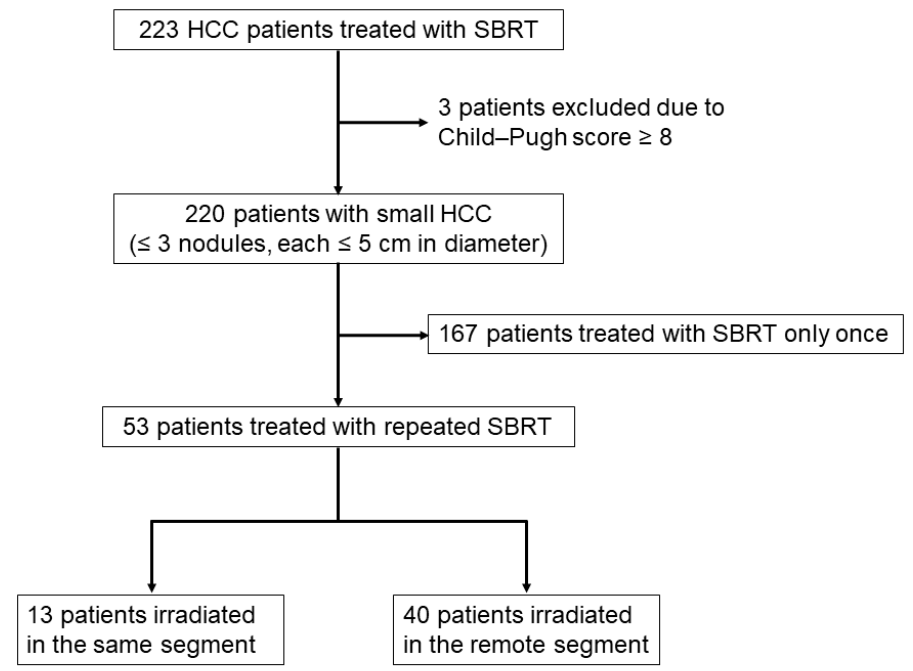
Figure 1. Flow chart of patient selection in the study. Table 1. Background characteristics for total cases ( n = 220) and repeated cases ( n = 53).